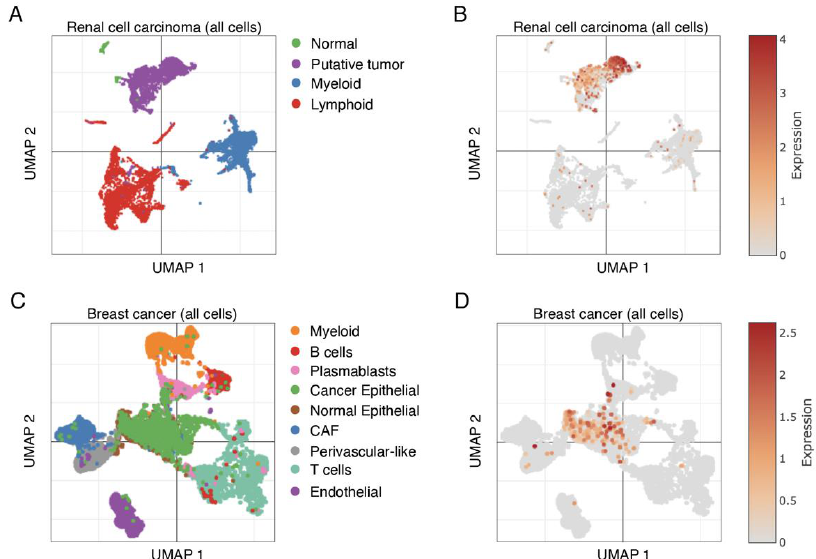
Figure 2. LRP2 expression is largely restricted to malignant cells in the tumor microenvironment. ( A ) UMAP visualization of single-cell RNA sequencing data integrated across 8 advanced renal cell carcinoma tumors (subsampling 10.000 cells) and colored by lineage. ( B ) Log-normalized expression of LRP2 overlaid on UMAP from panel A. ( C ) UMAP visualization of single-cell RNA sequencing data integrated across 26 primary breast tumors (subsampling 10.000 cells) and colored by major cell type. ( D ) Log-normalized expression of LRP2 overlaid on UMAP from panel C. CAF: cancer associated fibroblasts.